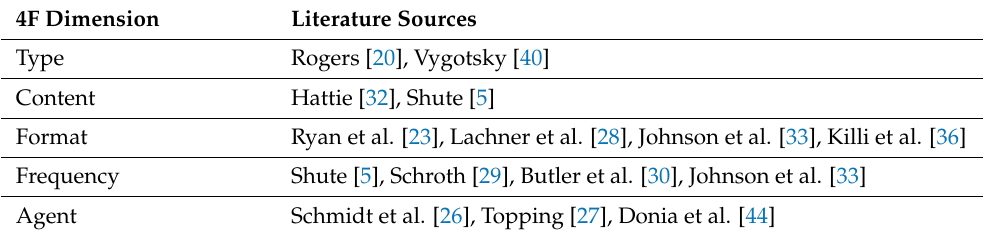
Table 1. Summary of key